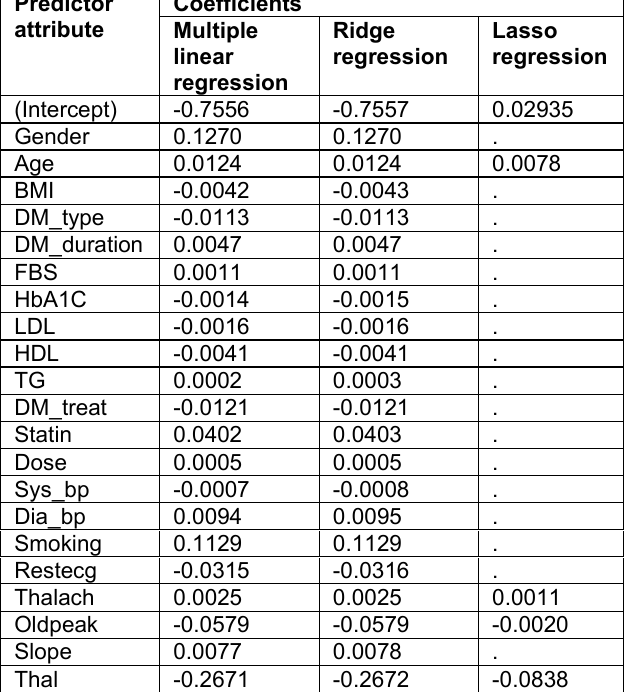
Table 2. Coefficients estimated by